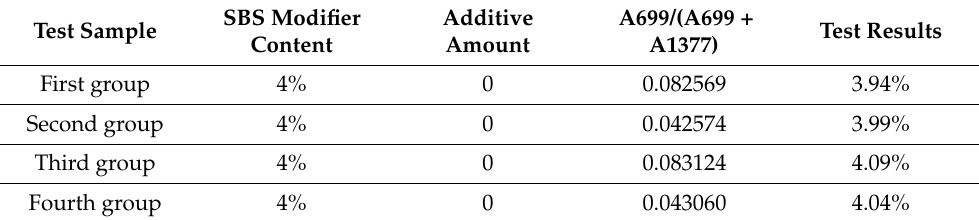
Table 9. Test results of 4% SBS-modified asphalt without additives.